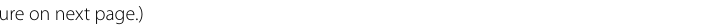
figure on next Fig. 8 Analysis of protein changes in testis and sperm of C11orf94 -deficient mice by mass spectrometry. a Venn diagram analysis of differential genes between testis and sperm. There are 1070 differential genes in testis and 2425 differential genes in sperm between C11orf94 + / + and C11orf94 −/− mice . b Go analysis of differentially expressed overlapping proteins in testis and sperm. c - d Analysis of differential genes related to Ca. 2 + signalling pathway ( c ) and sperm-oocyte fusion ( d ) in mature spermatozoa ( n 3) (*, p < 0.05; **, p < 0.01; ***, p < =